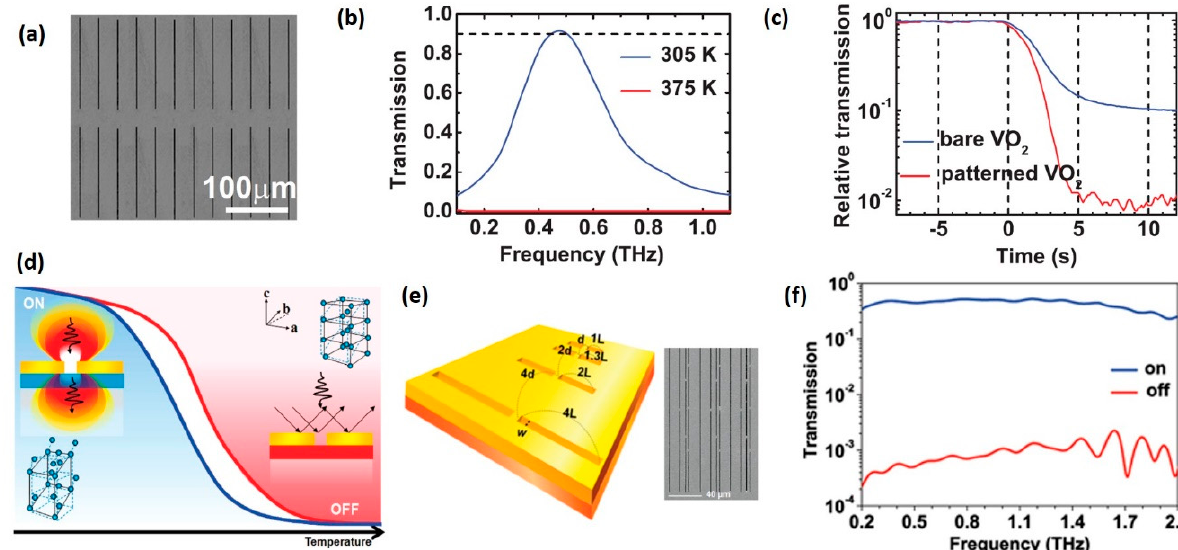
Figure 12. THz modulator with high extinction ratio. ( a ) SEM image of the nanoslot-antenna/VO 2 film sample. (100 um period, 150 µ m length and 450 nm width). ( b ) Transmission spectra at the insulator and metal state of VO 2 . ( c ) THz switching time measurements for the bare (blue line) and patterned (red line) samples when the structural phase transition of VO 2 is driven by thermal heating. Reproduced from [24], with permission from American Institute of Physics 2011. ( d ) Phase transition diagram of the nanopatterned VO 2 thin film as a function of temperature, based on the THz transmission. ( e ) Schematic of broad-band gold resonator patterns on a VO 2 thin film (left). SEM image (right) of a nanoresonator pattern sample (350 nm width and 50 μ m, 65 μ m, 100 μ m and 200 μ m lengths with 3 μ m, 7 μ m and 13 μ m separations). ( f ) THz transmittances (logarithmic plot) at 0.2–2.0 THz for 305 K (blue lines) and 375 K (red lines).Reproduced from [23], with permission from American Chemical Society 2010.